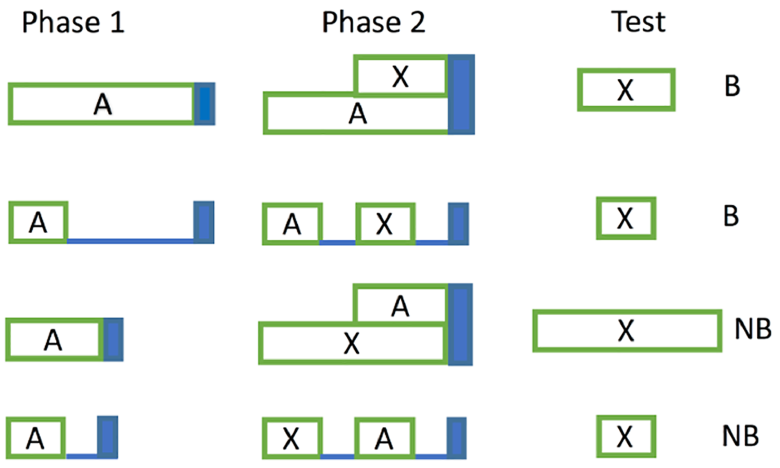
Fig 7. Experimental designs from two blocking experiments. CS X was blocked(B) in rows 1 and 2, and not blocked(NB) in rows 3 and 4. Blue bar indicatesUS presence.